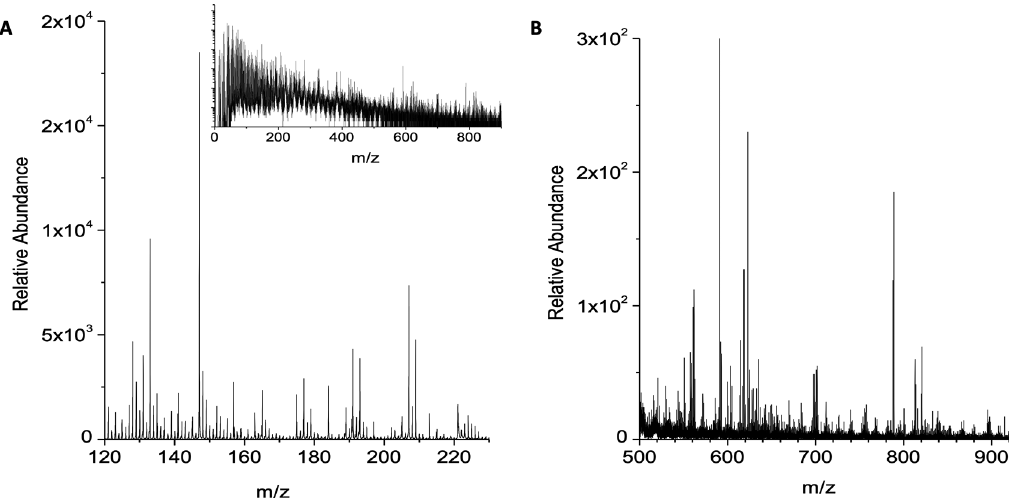
Figure 2. Representative TOF-SIMS positive ion HCBU mode spectrum of D. discoideum cells developed on a Au/Sisubstrate(250 (cid:1) 250 μ mfieldofview). AandBshowselectedregionsofthespectrum;insertshowstheentire spectrum. Data are representative of 3 independent